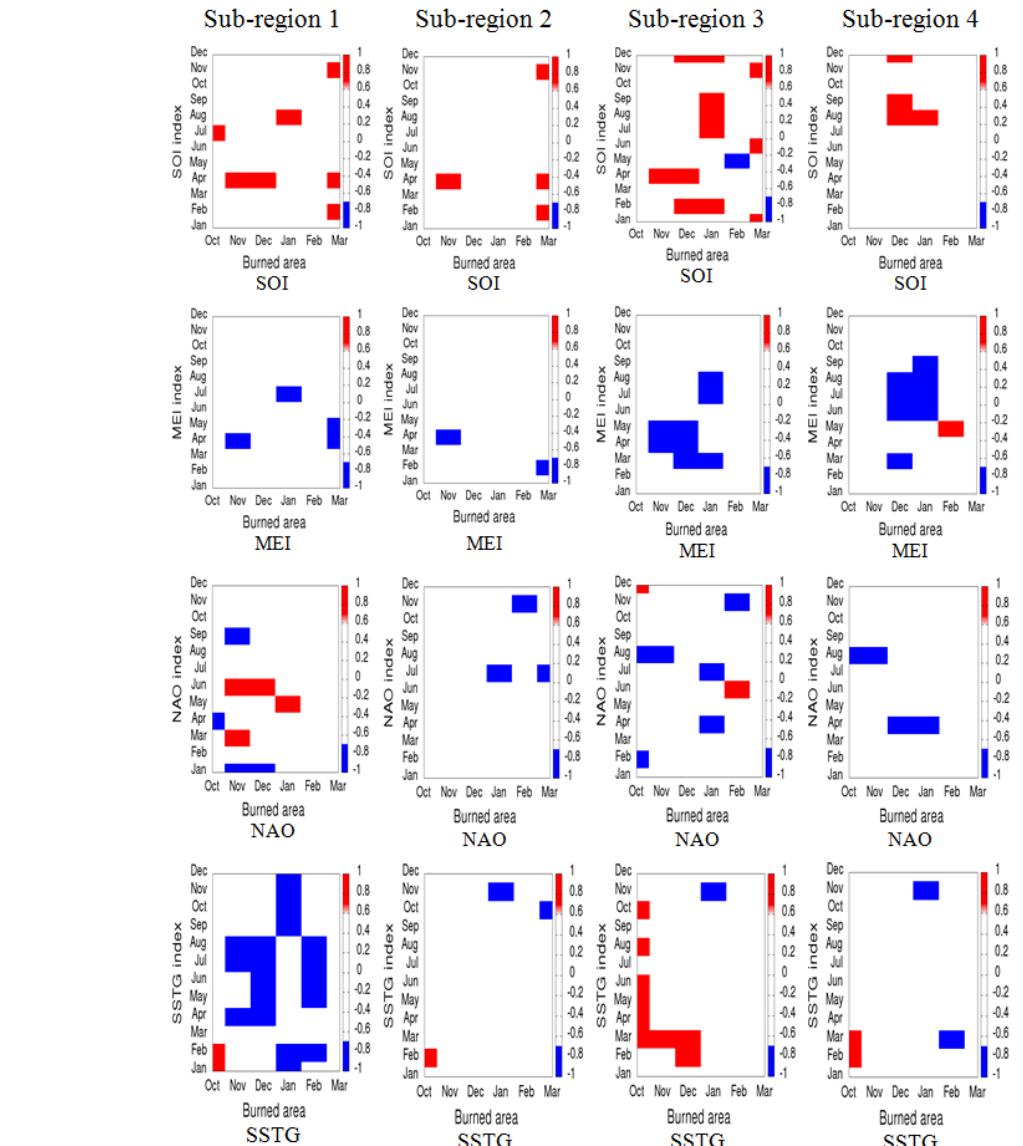
Figure 9. Significant correlations ( ≥ 0.7) between monthly burned areas and climate indexes (red for positive correlations and blue for negative correlations) for the four